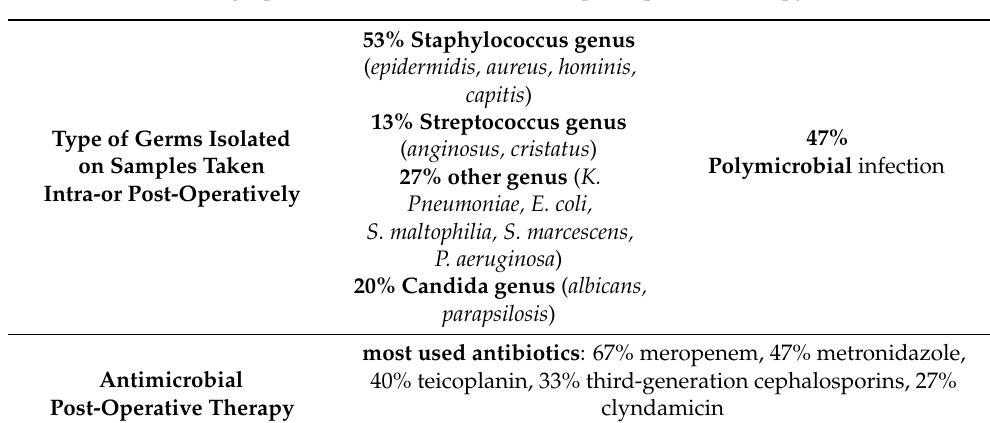
Table 2. Data relating to the type of germs isolated on samples taken intra- or post-operatively (blood culture, bronchial lavage, pleural fluid) and antimicrobial post-operative therapy.